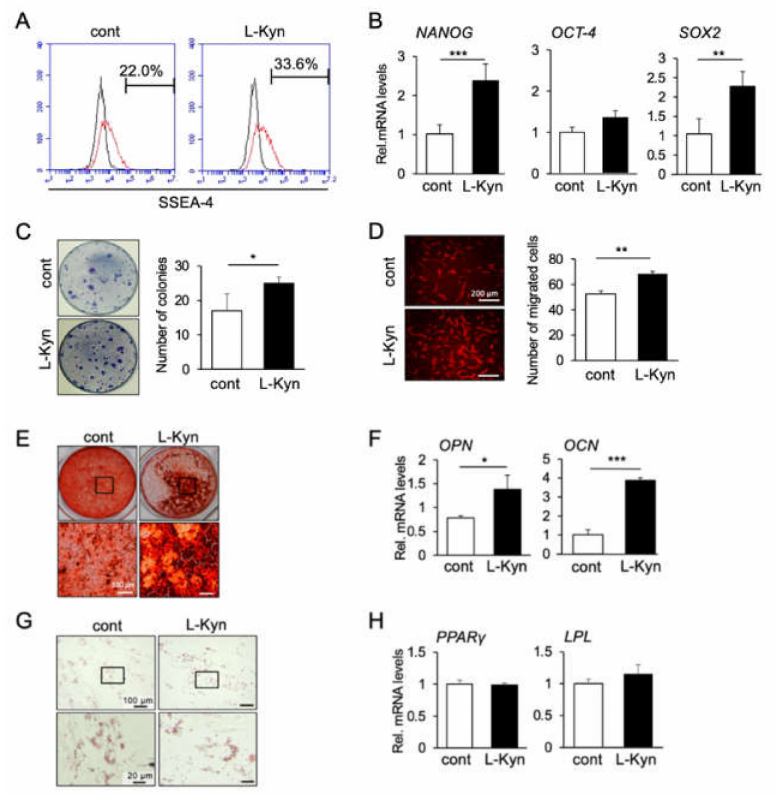
Figure 4. Effect of L-kynurenine on the stemness, function and differentiation capability of human bone marrow-derived mesenchymal stromal cells in vitro. ( A ) Flow cytometry showed the cells cultured with L-Kyn had a higher percentage positive with SSEA-4 + cells compared to control samples. ( B ) L-Kyn increased the gene expression levels of NANOG , OCT-4 , SOX2 . ** p < 0.01, *** p < 0.001, unpaired t -test. Data are representative of at least three independent experiments. ( C ) A higher number of colonies was observed in L-Kyn-treated group. Data represent the mean ± SD (n = 3). * p < 0.05, unpaired t -test. ( D ) hBMSCs treated with L-Kyn presented higher migration ability. Images are representative of three independent experiments. Scale bar = 100 µ M. Graph shows the average number of migrated cells counted in four different pictures taken in each chamber. ** p < 0.01, unpaired t -test. ( E , F ) L-Kyn-treated hBMSCs presented stronger deposition of the calcified matrix as detected by Alizarin Red S staining ( E ) as well as an increase in the mRNA levels of Opn and Ocn ( F ). No change in adipogenesis of hBMSC was observed after treatment with L-Kyn ( G , H ). * p < 0.05, *** p < 0.001, unpaired t -test. Images and graphs are representative of at least three independent